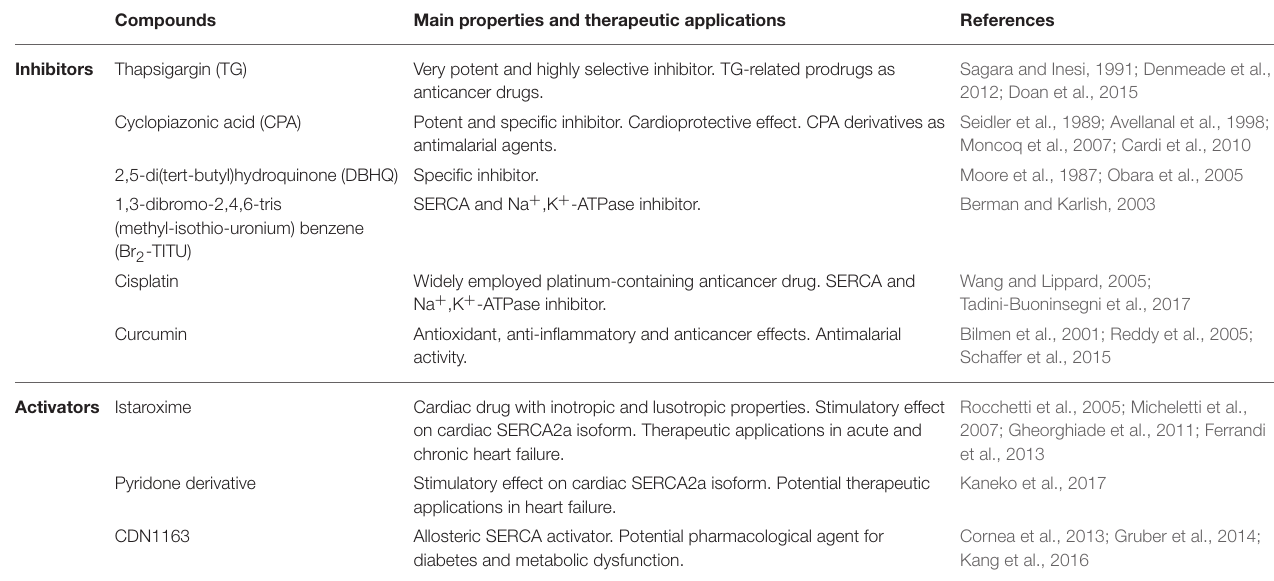
TABLE 1 | SERCA inhibitors and activators cited in the text.